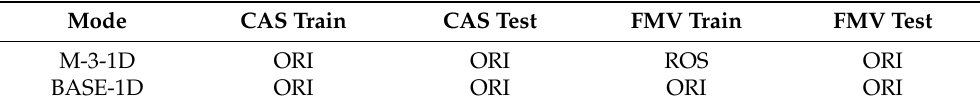
Table 4. Dataset processing mode settings for different strategies of 1D model.